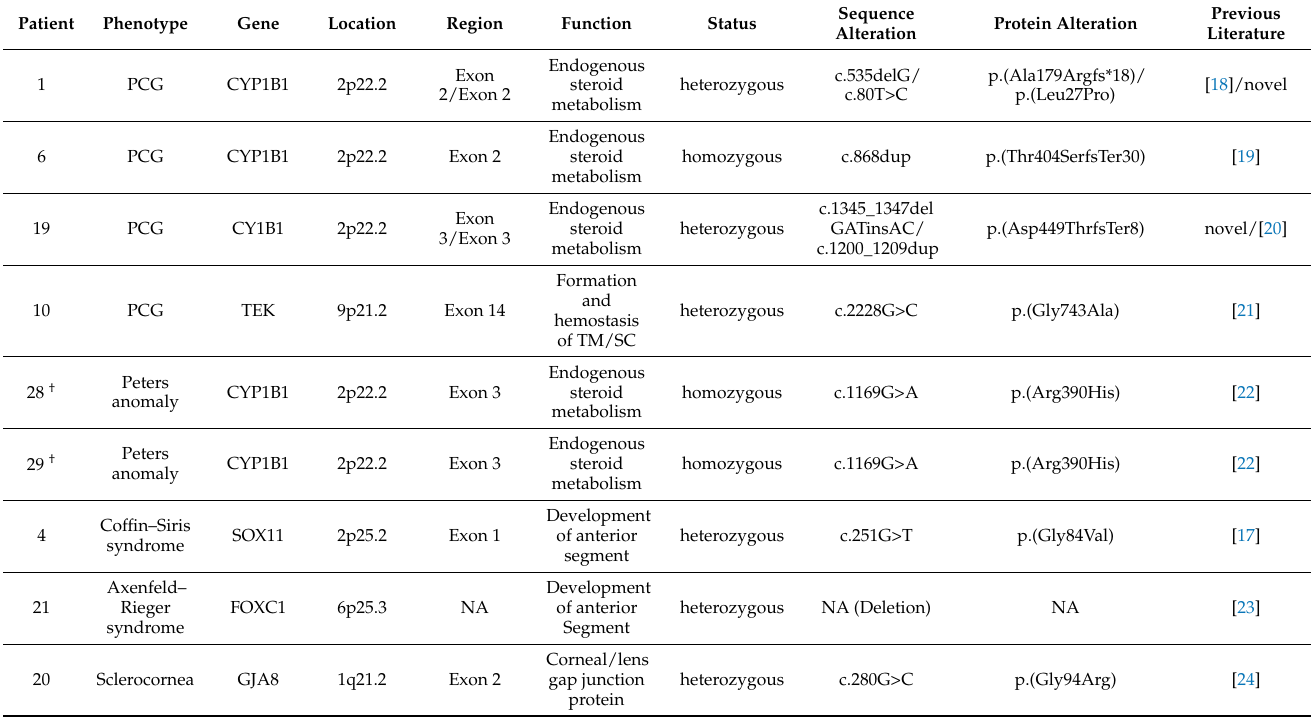
Table 5. Genetic variants in childhood glaucoma